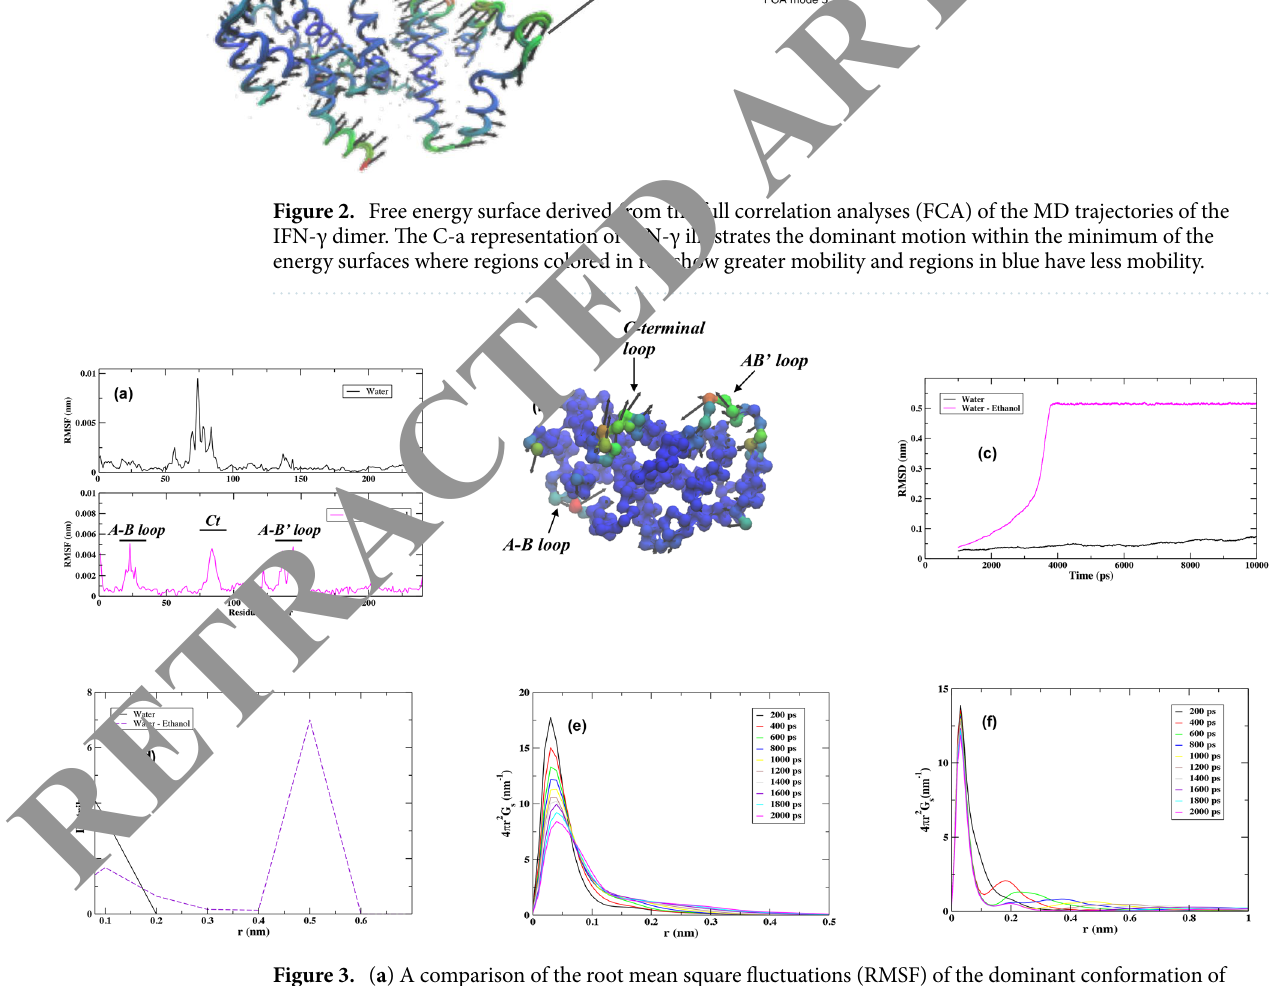
Figure 3. ( a ) A comparison of the root mean square fluctuations (RMSF) of the dominant conformation of IFN-γ in water vs a water–ethanol solvent. ( b ) The C-a representation of the dominant conformational mode of IFN-γ in the water–ethanol solvent from the MD simulation. Regions colored in red show greater mobility and regions in blue have less mobility. ( c ) A representative root mean square deviation (RMSD) of the MD simulations carried out on IFN-γ in water vs that in the water–ethanol solvent. ( e ) The C α –C α distribution of distances in IFN-γ from the RMSD calculation from ( d ). The van Hove self-correlation function of all atoms of IFN-γ in water ( e ) and ( f ) in the water–ethanol